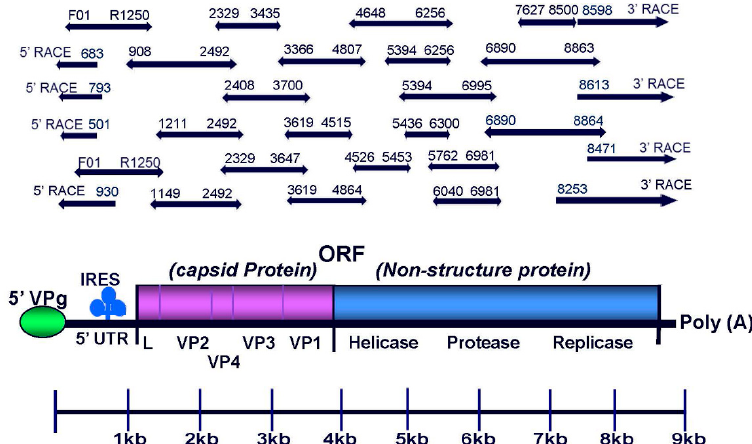
Figure 1. Schematic diagram of the Sacbrood virus (SBV) genome organization and overlapping